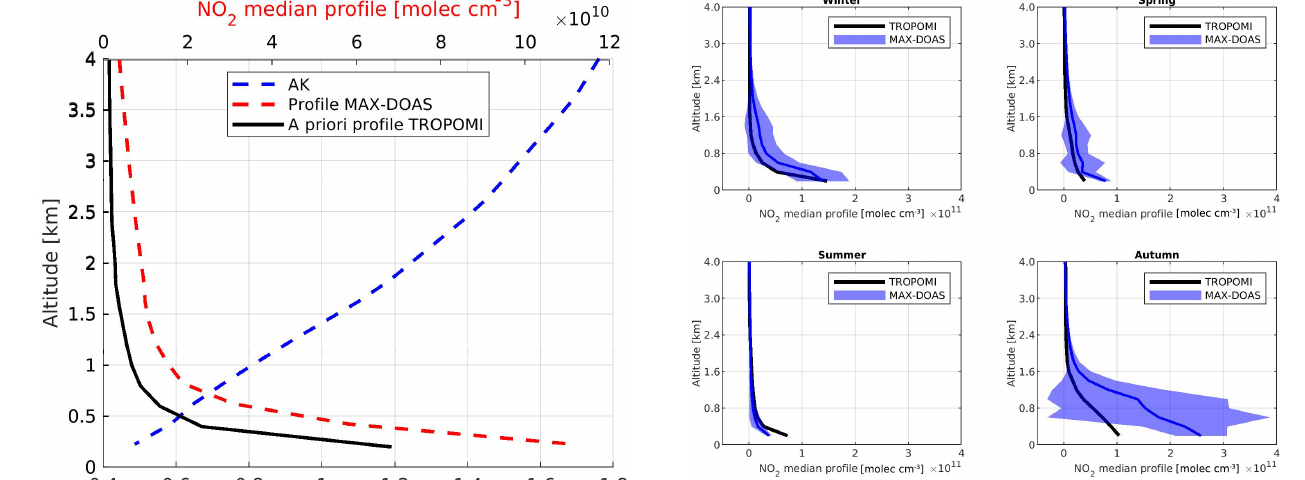
Figure 16. Example of median daily MAX-DOAS visible NO 2 profiles, which are used for the recalculation of the TROPOMI NO 2 columns (one example day per season: 3 March 2019, 12 Au- gust 2018, 29 October 2018 and 19 January 2019), and the a priori NO 2 profiles used in the TROPOMI retrieval in Uccle during the same example days. The shaded areas ( ± 1 σ ) represent the variabil- ity of the daily